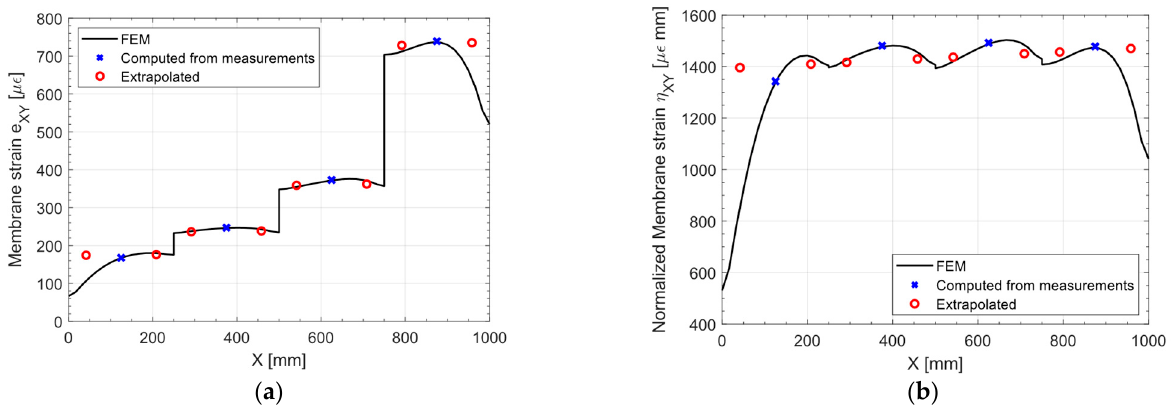
Figure 18 . Shear loading: ( a ) membrane strain 𝑒 (cid:3025)(cid:3026) and ( b ) normalized membrane strain 𝜂 (cid:3025)(cid:3026) , slice Figure 18. Shear loading: ( a ) membrane strain e XY and ( b ) normalized membrane strain η XY , slice at at Y = 250 mm. Y = 250 mm.